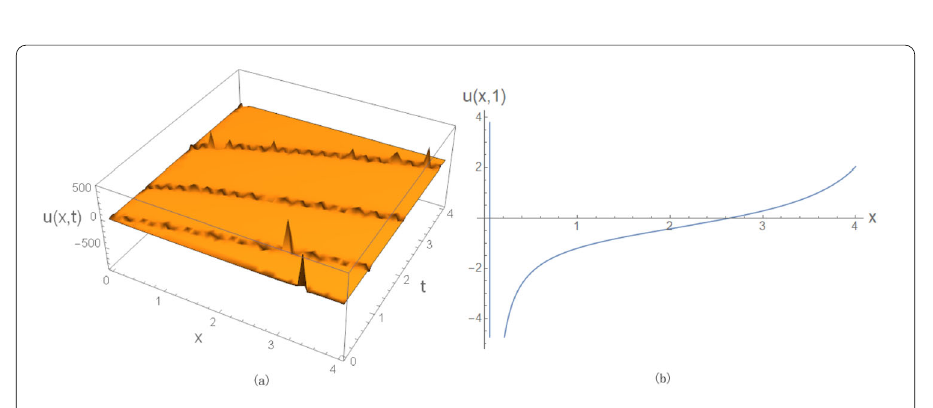
, and ξ 0 = 1; ( b ) the corresponding 2